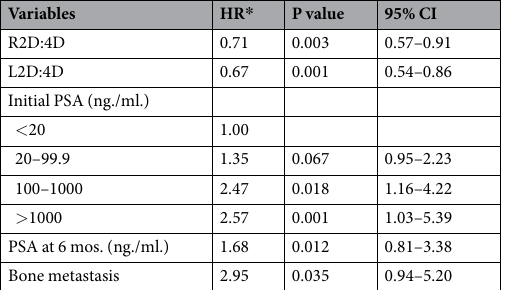
Table 4. Cox proportional hazards model for predicting any cancer progression (Hazards ratio estimates and 95% CI). All estimates adjusted. * Variables were used as categorical, as in Table 2.